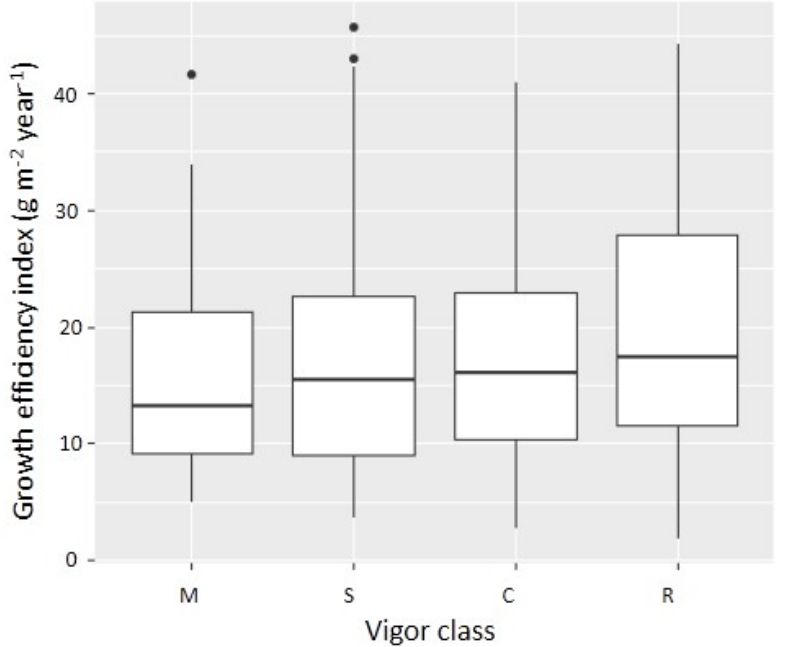
Figure 2. Box-and-whisker plots of the growth efficiency index as a function of tree vigor classes for the combined responses of sugar maple and yellow birch. The bold horizontal line within the boxes corresponds to the median (50th percentile), while the lower and upper limits of the boxes (interquartile range, IQR) represent the 25th and 75th percentiles, respectively. The whiskers are upper and lower values of 1.5 × IQR, and the individual points are outliers.